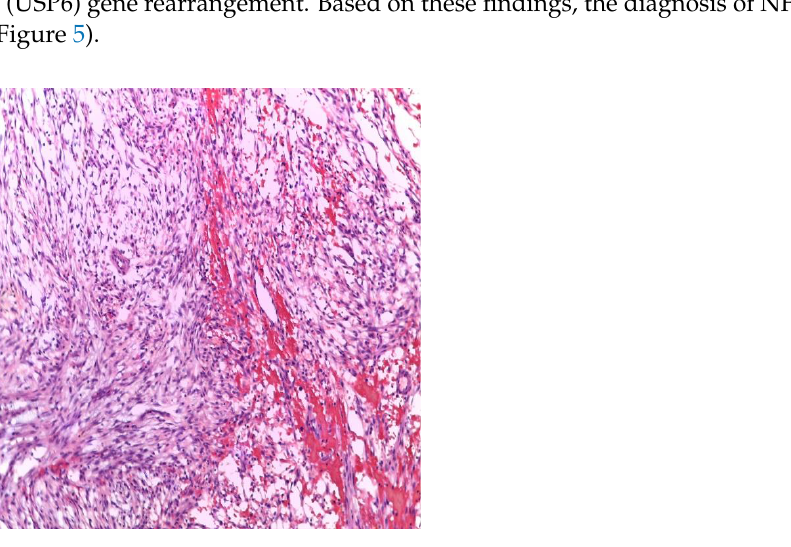
Figure 4. ( a ) Parotidectomy approach; ( b ) Identification of the mass; ( c ) Surgical area after removal of nodular fasciitis.